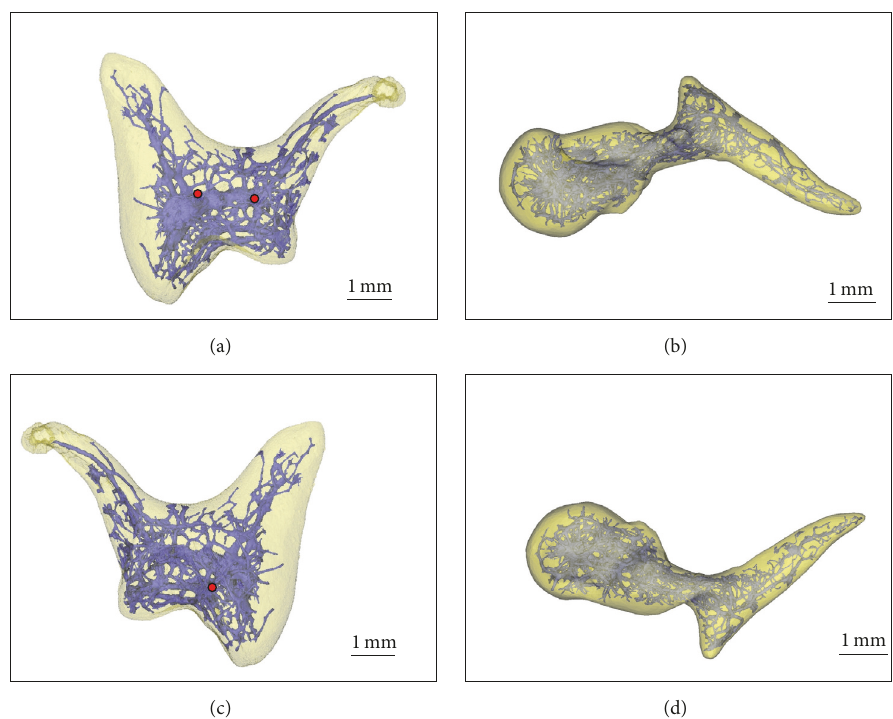
Figure 4: 3D models of the 𝜇 CT data of the separated scanned incus (a, c) and malleus (b, d) in the lateral (a, b) and medial aspect (c, d), respectively. In the half-transparent ossicles the bone structure is colored in yellow, the not calcified inner structures are colored in blue, and nutrient foramina are marked in red.